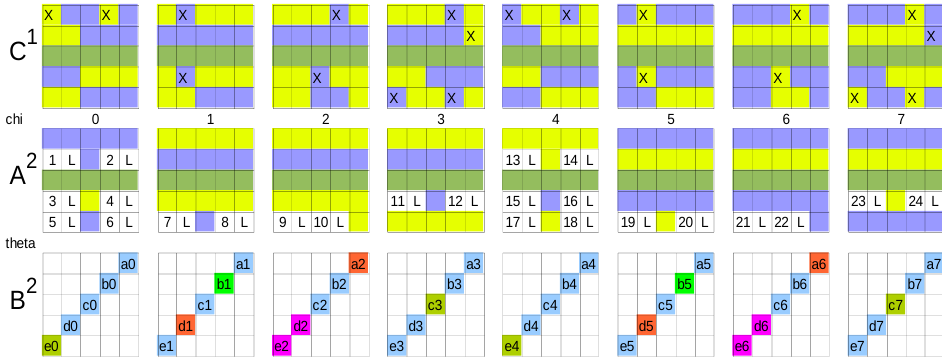
Figure 12: The bits with X in C 1 are the 20 bits we guess, hence only 24 quadratic variables remain (denoted with 1,